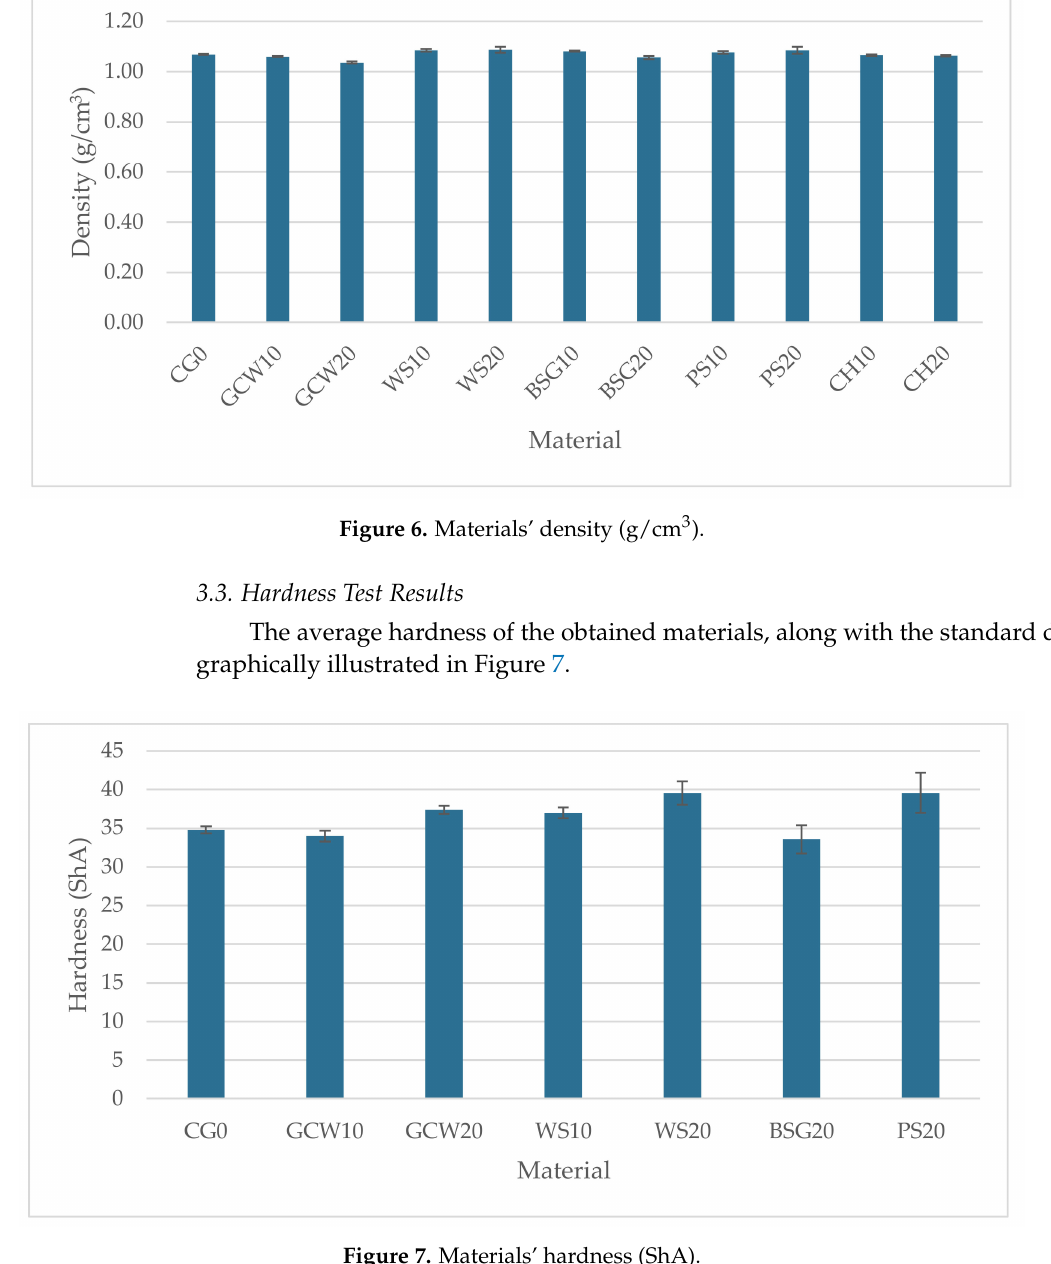
Figure 7. Materials’ hardness